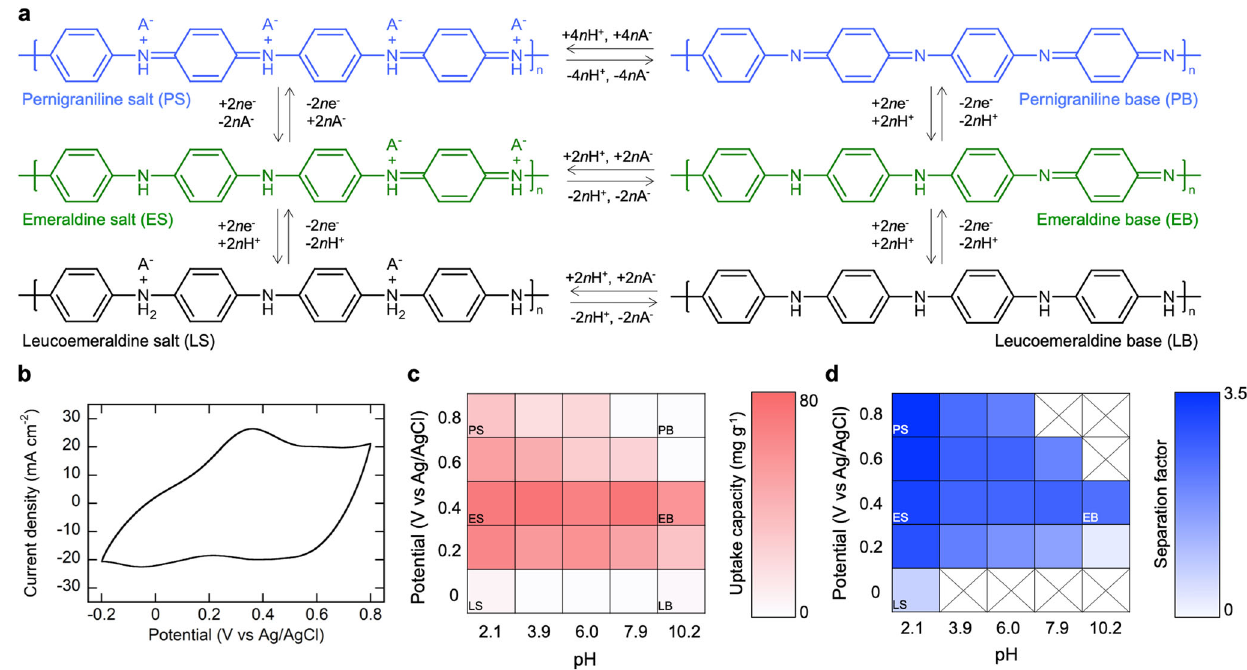
Fig. 4 | Structural effect of PANI species (leucoemeraldine, emeraldine, and pernigraniline) onselective capture ofnitrate. a Redox-interconversion of PANI caused by the change in electrode potential and solution pH. b A cyclic voltam- mogram of a PANI/CNT electrode in 0.5M H 2 SO 4 . Scan rate was 5mVs − 1 . c A heatmap of nitrate uptake capacity (mgNO 3 − g − 1 PANI) at various pH and electrode